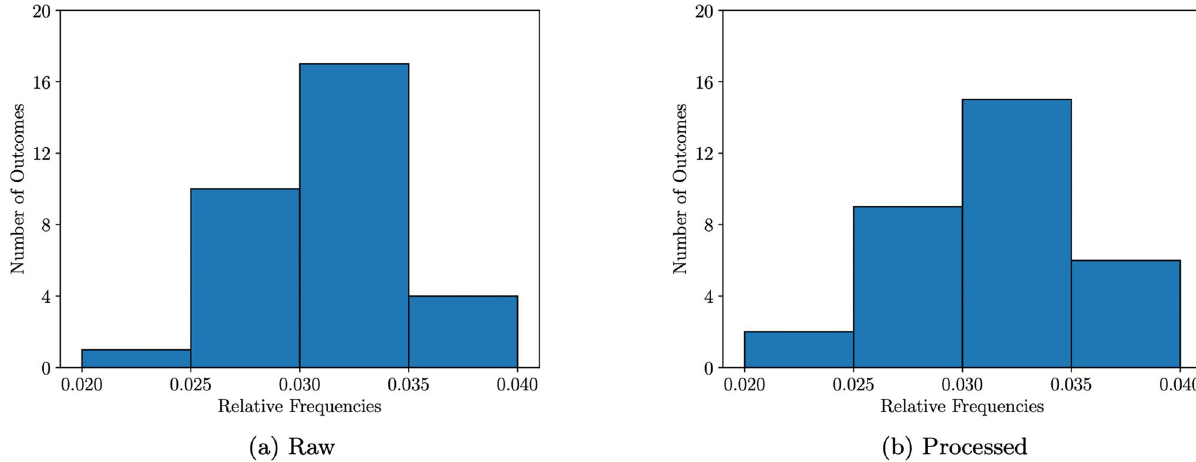
Figure 6. Distribution of relative frequencies with which the 32 random unitaries are generated with the exact 3-design on the ibmq_toronto quantum processor. ( a ) Raw shows the distribution without quantum readout error mitigation. ( b ) Processed shows the distribution with quantum readout error mitigation.